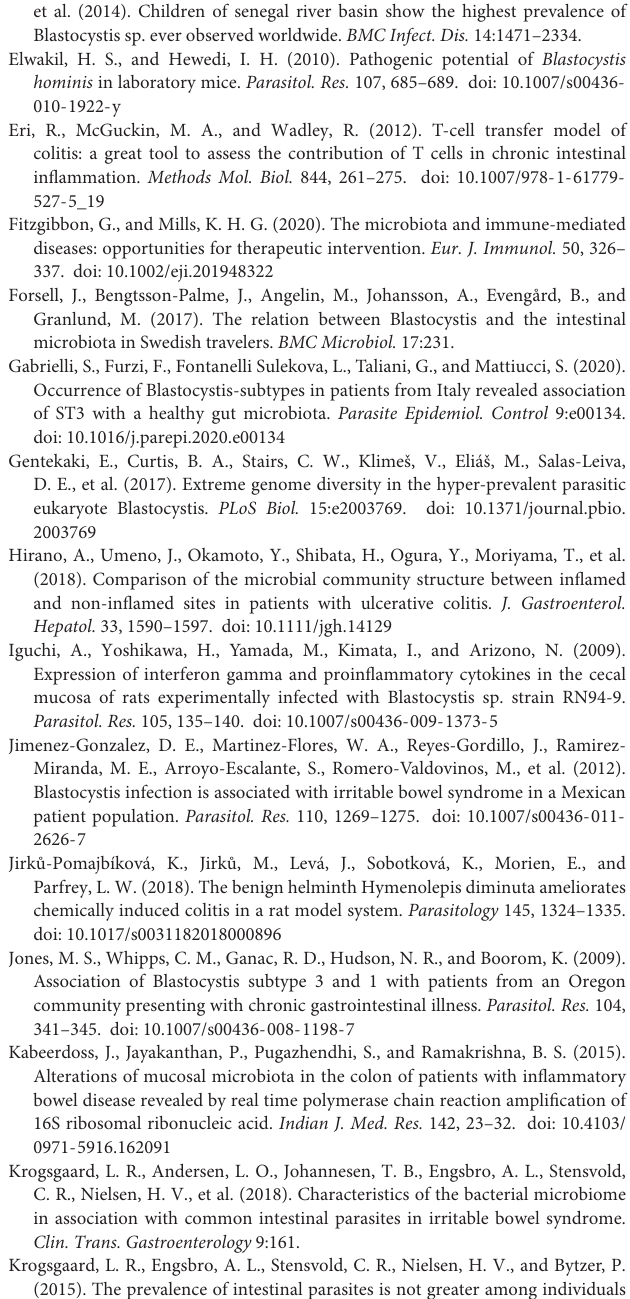
Supplementary Figure 5 | Effect of Blastocystis ST3 colonization on rat gut bacterial diversity in the short-term Pilot study A and the long-term Pilot study B. NMDS plots of Bray-Curtis dissimilarity visualize the difference in gut microbiota composition from fecal samples between the control group (warm shades) and rats colonized by Blastocystis ST3 (cool shades). (A) Short-term Pilot study A before Blastocystis ST3 colonization. (B) Long-term Pilot study B before Blastocystis ST3 colonization. (C) Short-term Pilot study Aafter Blastocystis ST3 colonization. (D) Long-term Pilot study Bafter Blastocystis ST3 colonization. Differences between groups are calculated with a PERMANOVA on combined days (those shown in each panel) followed by Benjamini-Hochberg